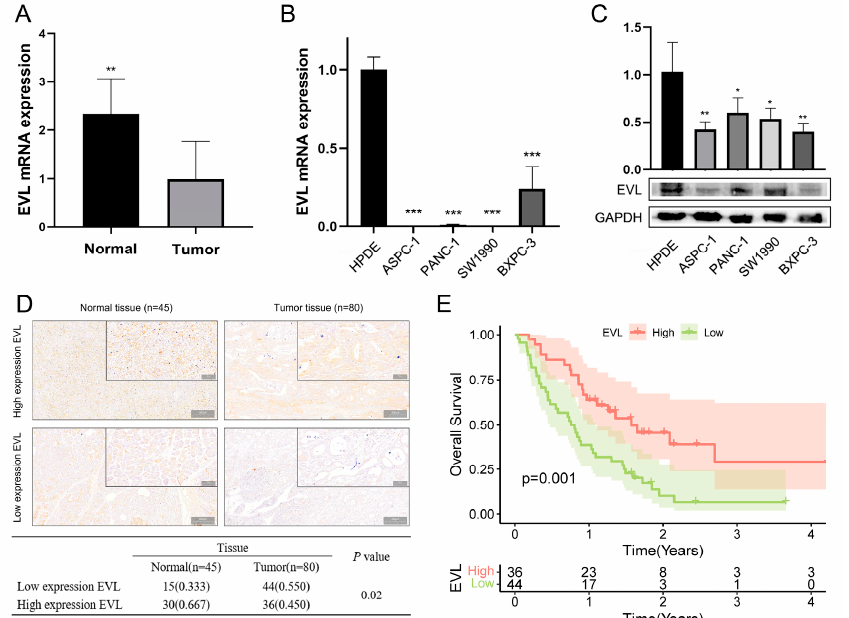
Figure 7. Validating the expression differences of EVL. ( A , B ) qRT-PCR analysis of EVL expression in clinical samples and PC cell lines. ( C ) WB analysis of EVL expression in PC cell lines. ( D ) EVL expression was determined by immunochemistry. ( E ) Kaplan-Meier survival curve between the EVL-high and EVL-low groups. * p < 0.05; ** p < 0.01; *** p < 0.001.